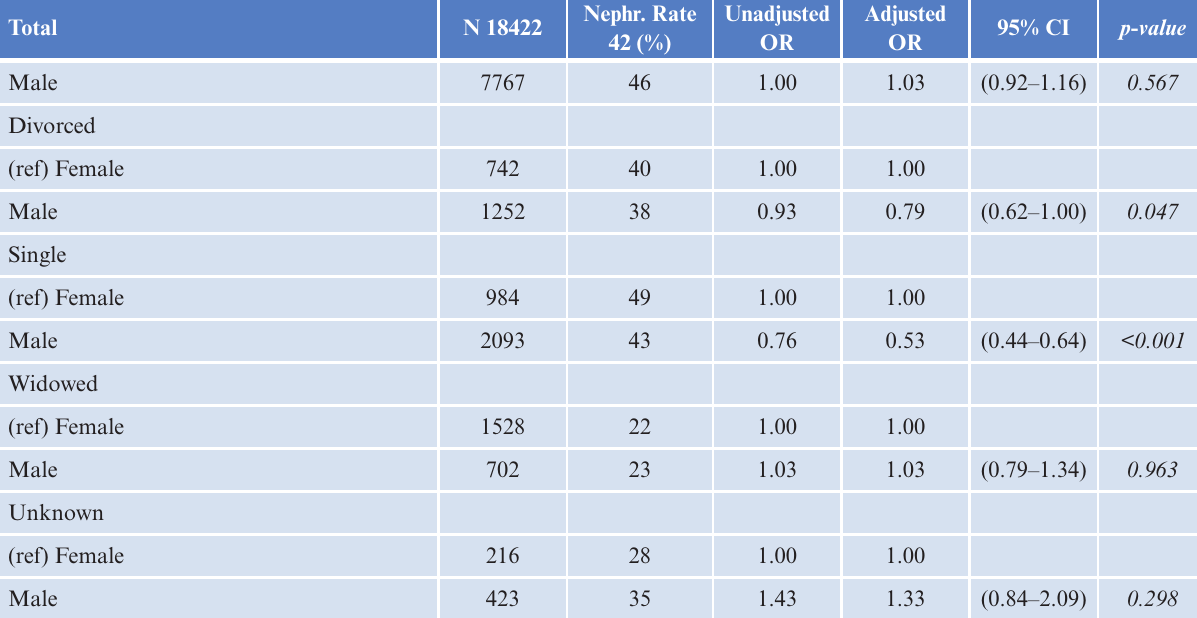
Table 2 (Continued): All SEER Distant Stage Kidney Cancer: 2000–2013; Odd Ratios for Likelihood of